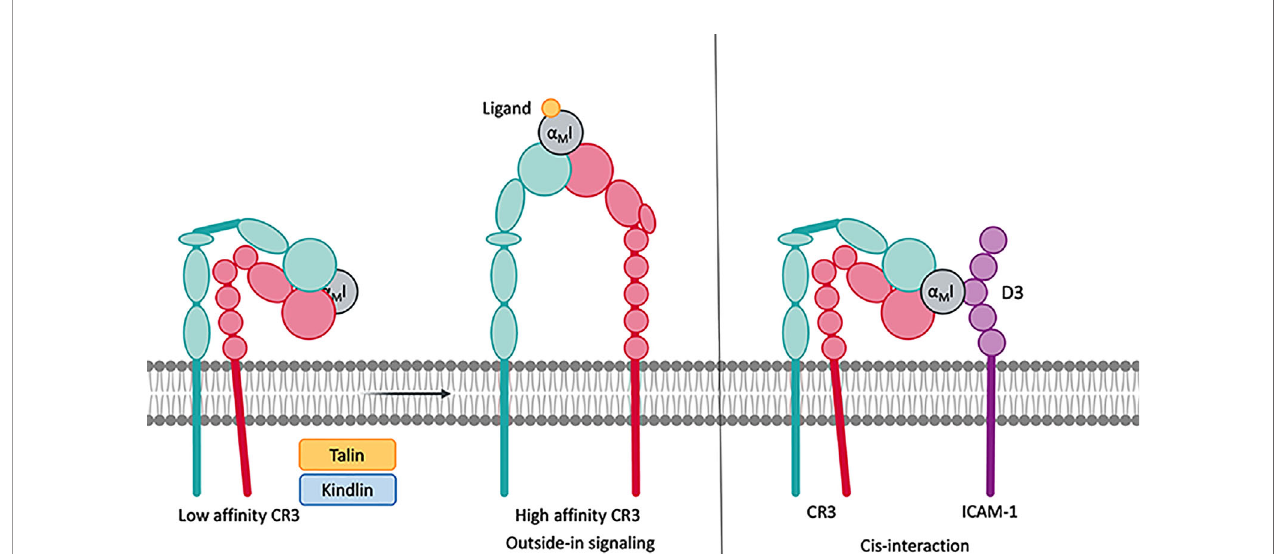
FIGURE 2 | Integrins remain in a low af fi nity, bent-closed state. Cytoplasmic factors such as talin and kindlin connect the cytoplasmic tail of the integrins to the cytoskeleton. This leads to an extension of the extracellular domains with an open, high af fi nity, ligand accessible headpiece. CR3 is able to bind to protein on the same surface, which is termed